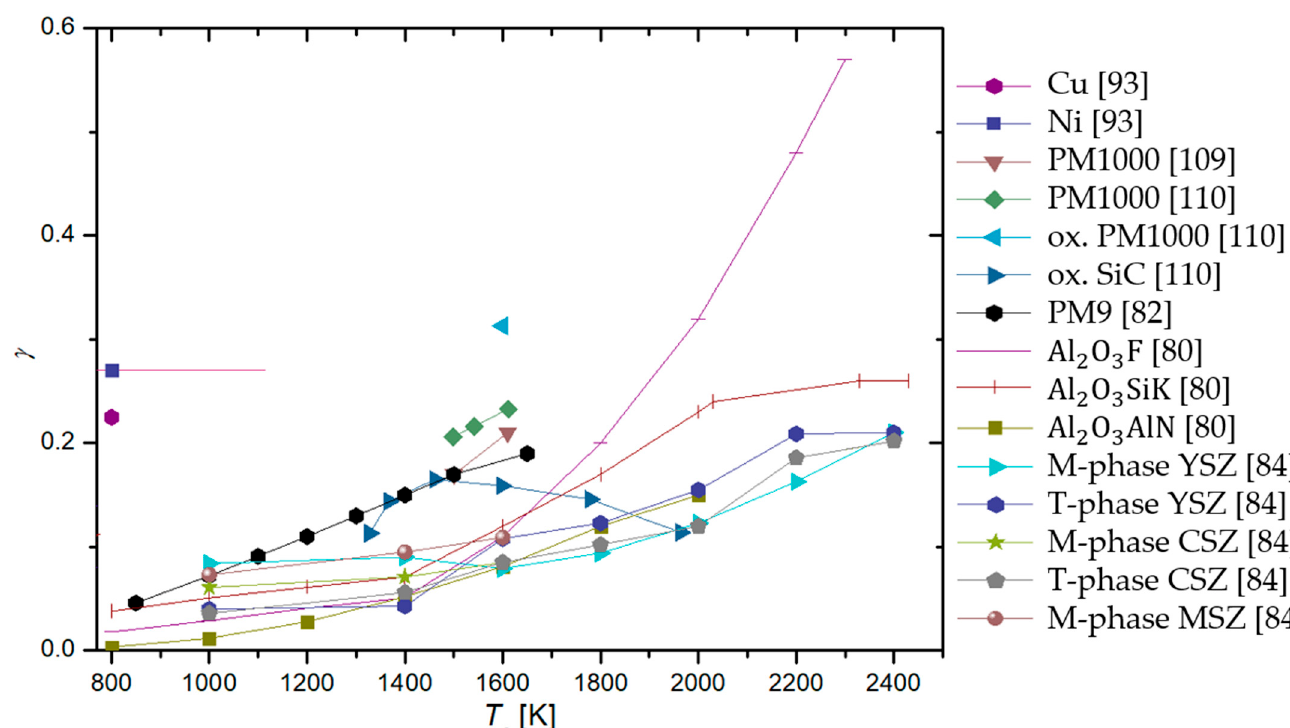
Figure 16. Recombination coefficient ( γ ) of neutral oxygen atoms versus surface temperature ( T s ) for various catalytic surfaces.